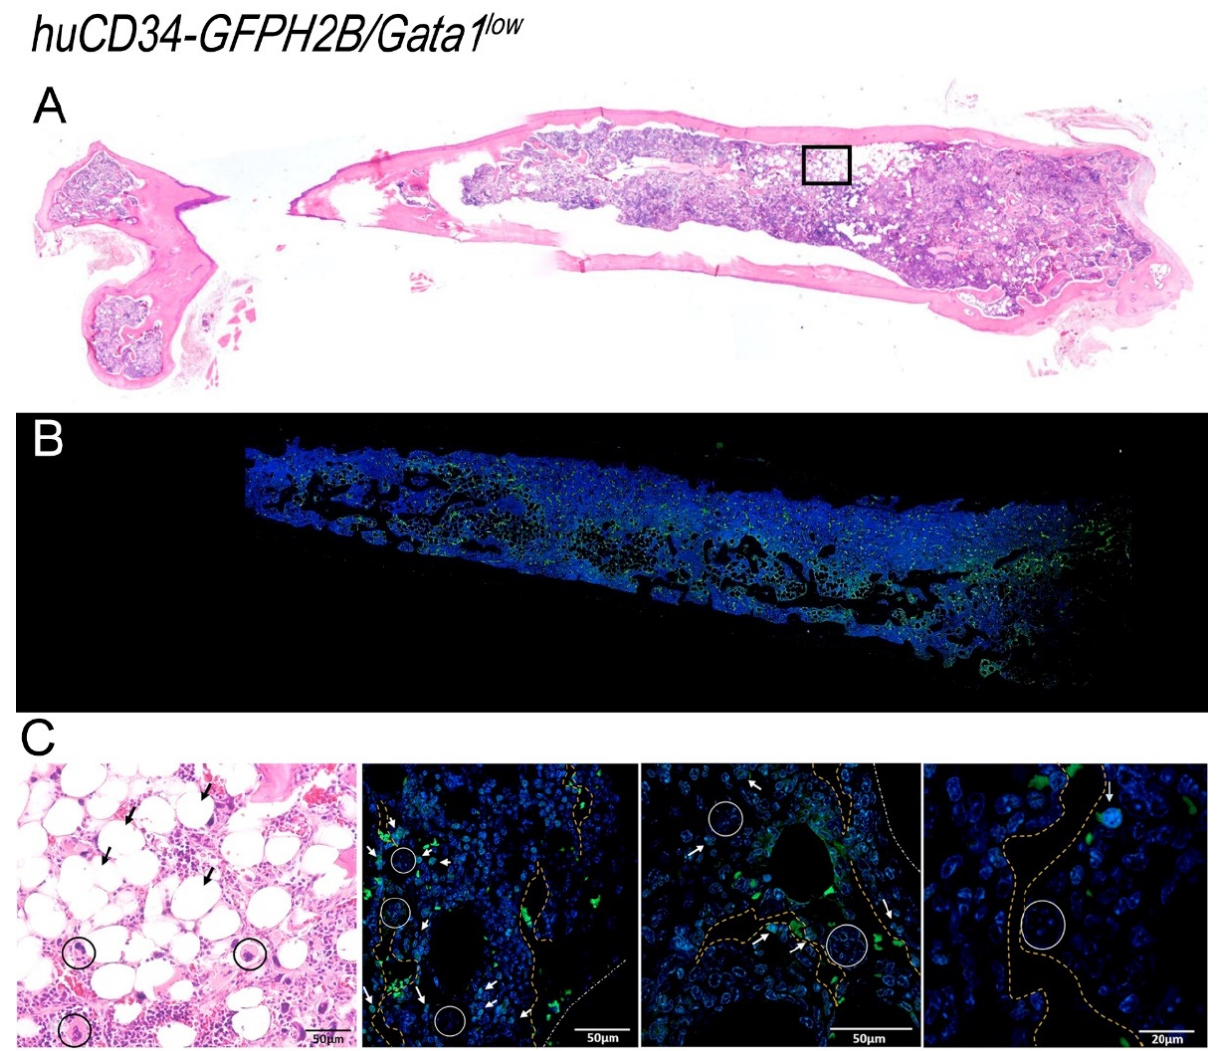
ond panel of the left). The rectangle on the second panel on the left is shown as stack image and as tridimensional reconstruction on the right. The tridimensional reconstruction is shown in detail in movie 3. Black arrows in A indicate adipocytes, circles indicate megakaryocyte clusters, and white arrows indicate GFP-positive cells. A and B are a photo-merge of 4× magnification pictures; in C, the magnifications are 20× for the first and second panel, and 40× for the third and fourth panel.